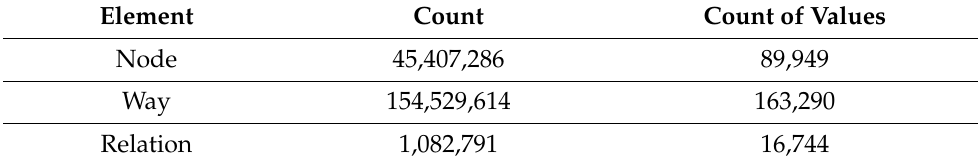
Table 1. Global count of the tag key sources (retrieved on 3 January 2020 )